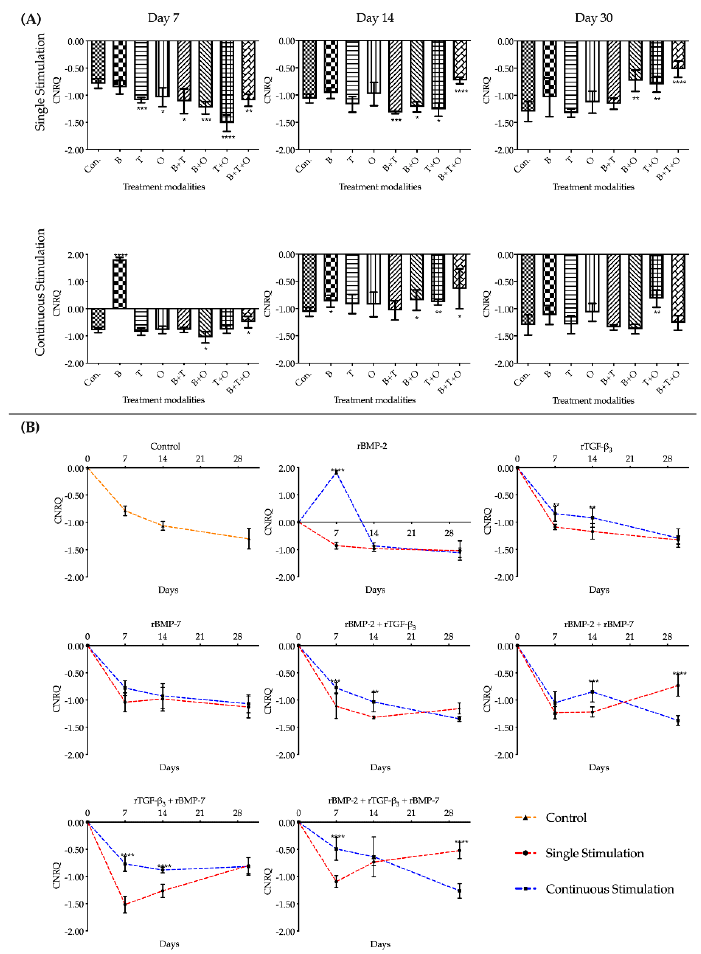
Figure 6. The analyses of the relative expression levels of alkaline phosphatase ( ALP ). The results were presented as calibrated normalized relative quantity (CNRQ). ( A ) Comparisons between each experimental group under different stimulation modes and the corresponding control group at day 7, 14 and 30 using one-way ANOVA. ( B ) Comparisons between the experimental groups where growth factors were applied continuously and the corresponding 48 h withdrawal groups at day 7, 14 and 30 using two way ANOVA. Con. = control group, B = rBMP-2 treated group, T = rTGF- β 3 treated group, O = rBMP-7 treated group, B + T = rBMP-2 + rTGF- β 3 treated group, B + O = rBMP-2 + rBMP-7 treated group, T + O = rTGF- β 3 + rBMP-7 treated group, B + T + O = rBMP-2 + rTGF- β 3 + rBMP-7 treated group. Number